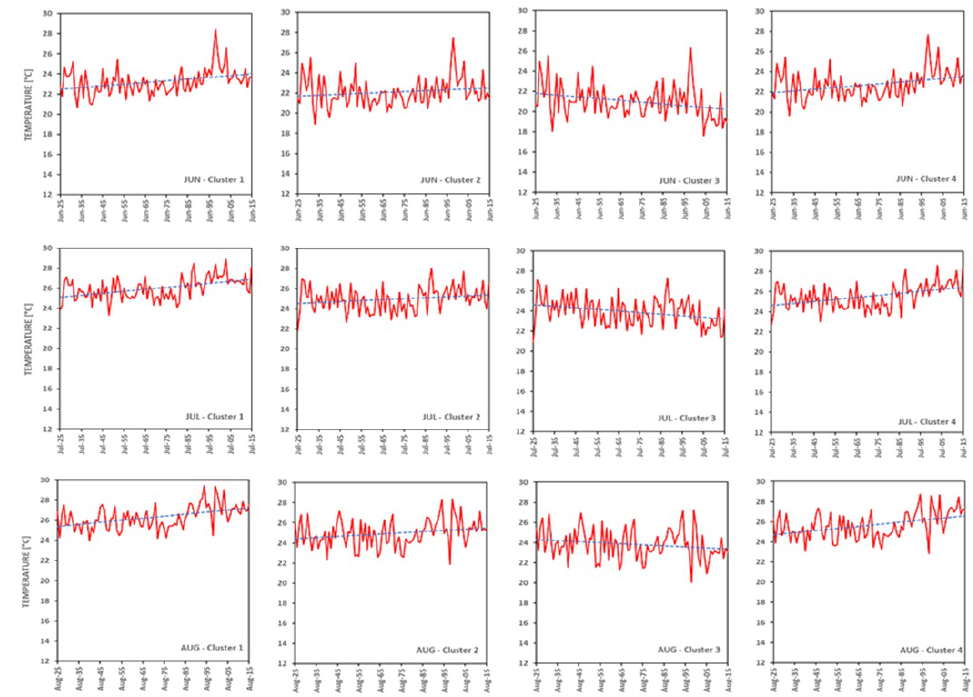
Figure 5. Trend of average monthly temperatures from 1925 to 2015 for each Cluster (quarter Jun-Jul- Aug).